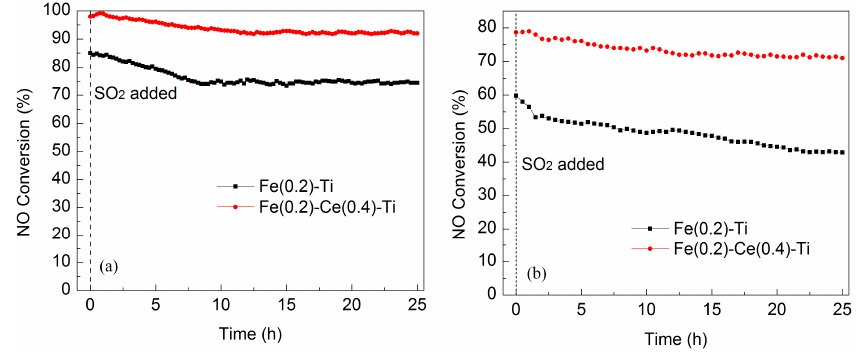
Figure 9. NO conversion of the Fe(0.2)–Ti and Fe(0.2)–Ce(0.4)–Ti catalysts in the presence of SO 2 at 270 °C under different GHSVs: ( a ) GHSV = 90,000 h − 1 and ( b ) GHSV = 150,000 h − 1 . Reaction conditions: [NO] = [NH 3 ] = 500 ppm, [SO 2 ] = 200 ppm, [O 2 ] = 5 vol. %, N 2 balance.